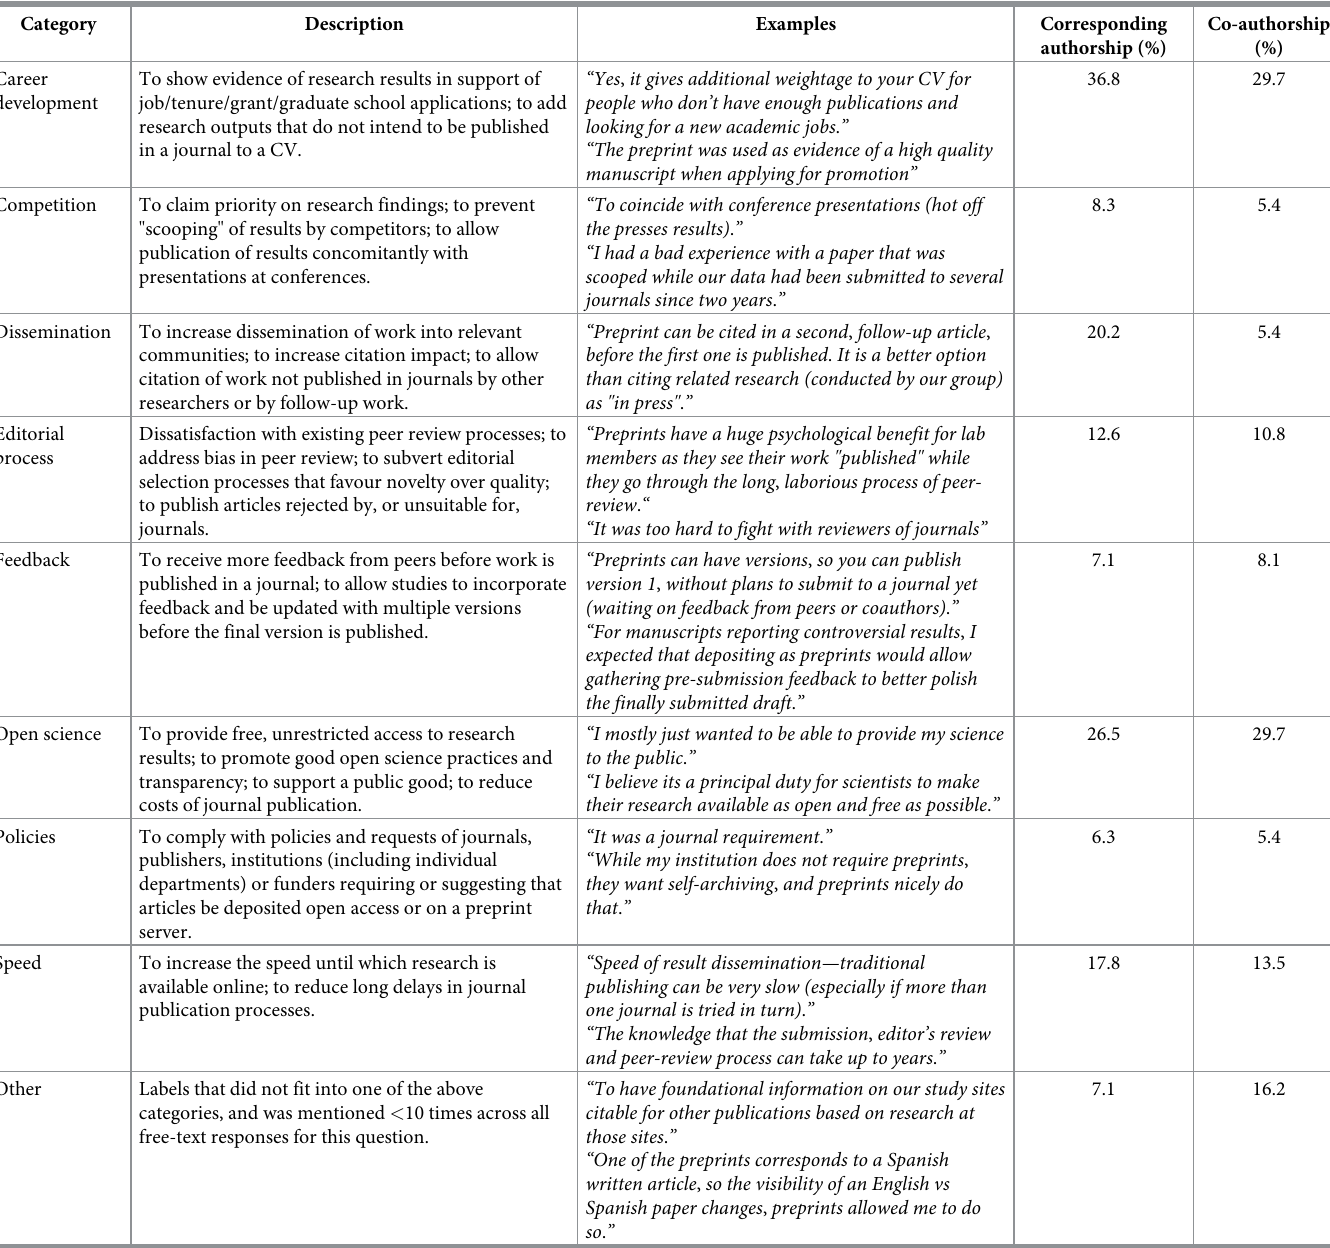
Table 4. Classification of free-text responses, in response to the question “Were there any additional reasons that motivated you to deposit these articles as pre- prints?”. Categories are ordered alphabetically (except for “Other”). Percentages for corresponding and co-authorships refer to the proportion of all responses containing the relevant category; responses could contain multiple categories (N = 253 comments on corresponding authorships, 38 comments on co-authorships). Category Description Career